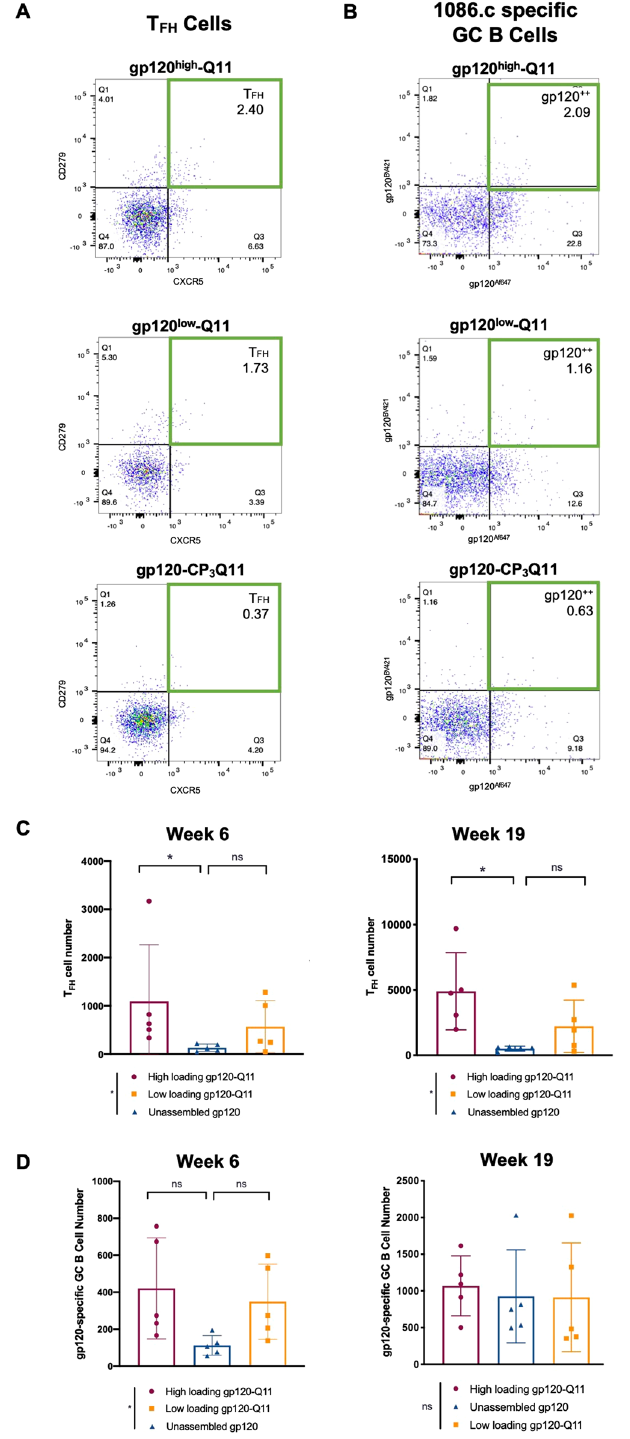
Figure 5. Antigen density on nanofibers modulates T FH and GC B cell numbers. ( A ) Representative dot plots of CD3 + CD4 + CD44 hi CD62L Lo CD25 - CD279 hi CXCR5 hi T follicular helper (T FH ) cells detected by flow cytometry at 6-weeks post priming immunization (gating strategy shown in Fig. S11). ( B ) Representative dot plots detecting gp120-specific CD138 - B220 + GL7 hi germinal center B cells detected by flow cytometry at 6-weeks post priming immunization (gating strategy shown in Fig. S12). ( C ) T FH cells from 6- and 19-weeks post primary immunization. In C and D, ranks were compared using the Kruskal–Wallis test to determine if there were significant differences among the groups, followed by post-hoc pairwise comparisons to test for differences between specific groups. Differences due to treatment group are shown in figure legends and differences between specific groups are shown above the data. ( D ) gp120-specific germinal center B cells at 6- and 19-weeks post primary immunization. The Kruskal–Wallis test indicated significant differences existed between treatment groups ( p = 0.04, indicated next to the figure legends), but Holm post-hoc pairwise comparisons were not statistically significant (* p < 0.05, indicated above the data). n = 5